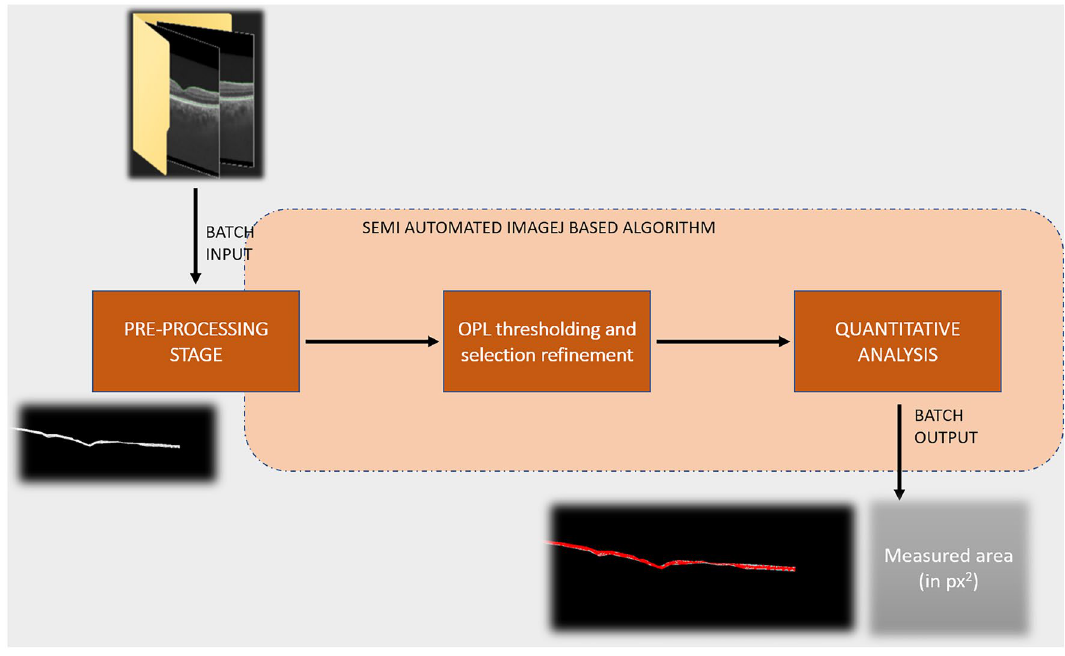
Figure 1. The figure shows the algorithm used in the semi-automated quantitative analysis of the outer plexiform layer (OPL) area in the included subjects in our study. The pre-processing stage consisted of randomization, anonymization and cropped using third party software (ImageJ). The subsequent automated stages included conversion to 8-bit and thresholding, and measurement of the area in square pixels.